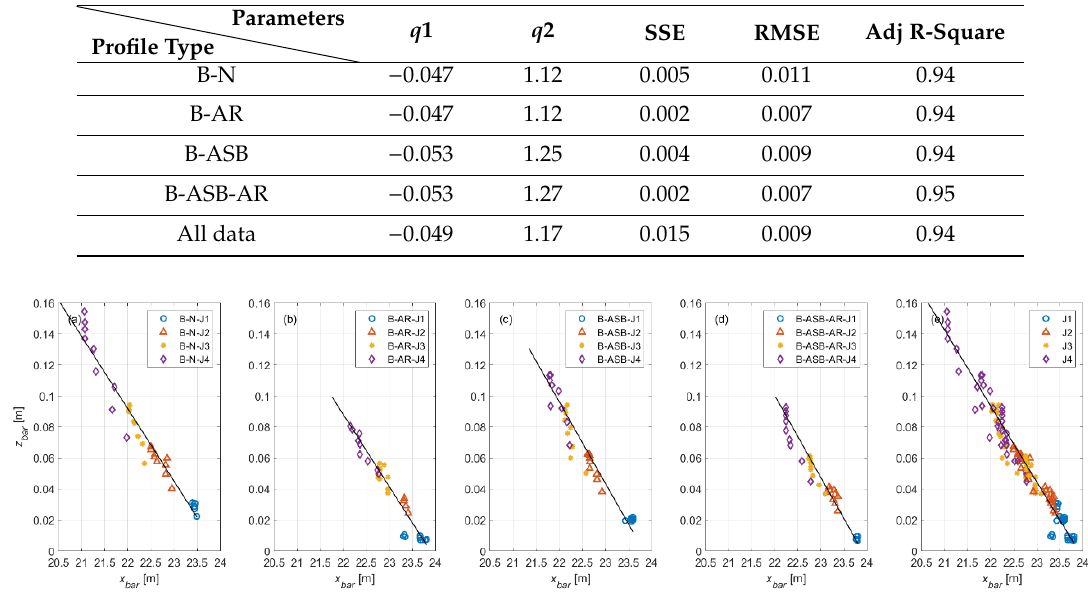
Figure 7. Comparison of breaker bar height z bar and location x bar between measurement (marks) and prediction (line). ( a – e